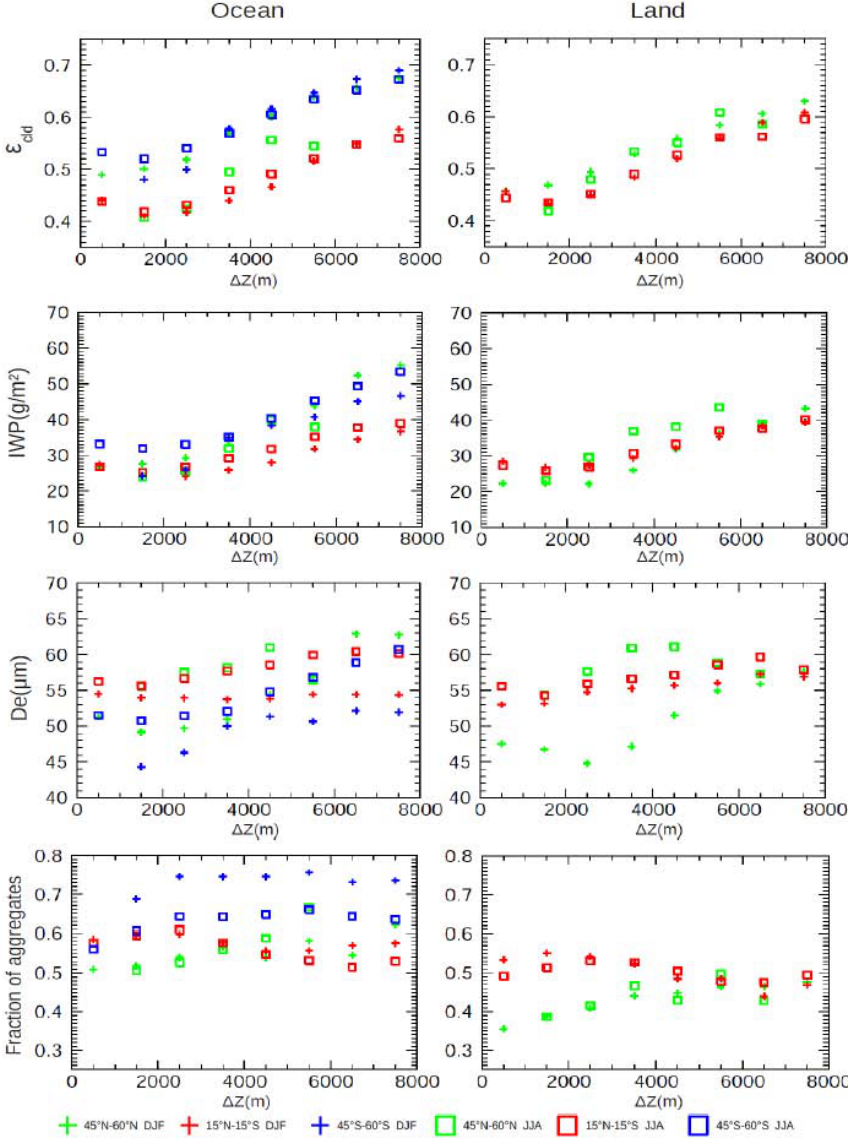
Fig. 13. Relationships between microphysical properties and vertical extent, separately over ocean (left) and over land (right). Green, red and blue signs stand for NH midlatitudes, tropics and SH midlatitudes, respectively. Plus signs and squares indicate boreal winter and boreal summer,